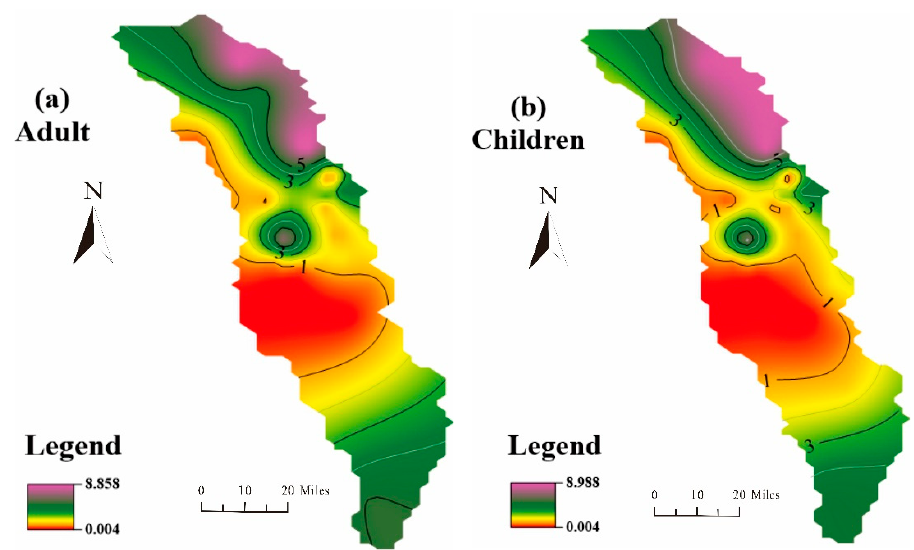
Figure 5. Health risk index distribution maps for adults and children.